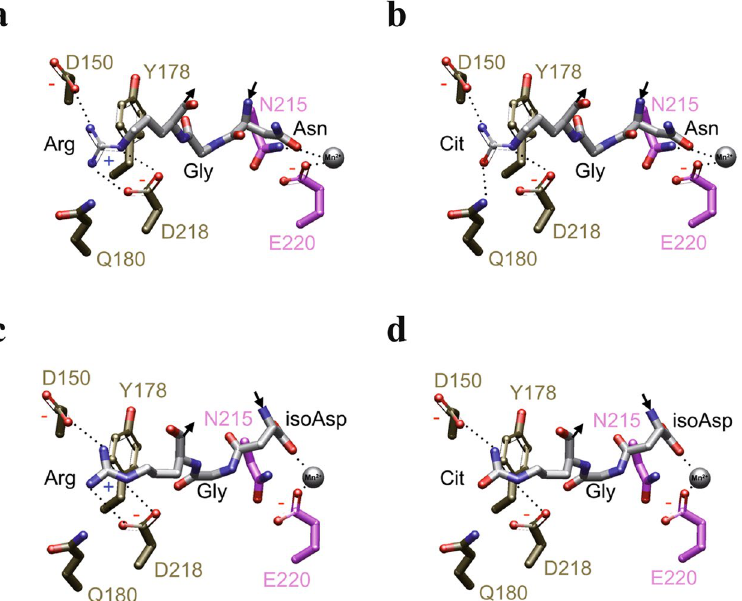
Figure 6. Citrullination inhibits integrin binding to isoDGR in fibronectin N-terminus. ( a ) Model of NGR at the binding site of α V β 3. ( b ) Model of NGcit at the binding site of α V β 3. ( c ) Model of isoDGR at the binding site of α V β 3. ( d ) Model of isoDGcit at the binding site of α V β 3. ( d – g ) NGR, NGcit, isoDGR and isoDGcit: white carbon atoms; Residues from α V: gold carbon atoms; Residues from β 3; pink carbon atoms; metal cation: silver sphere; potential hydrogen bonds: dotted